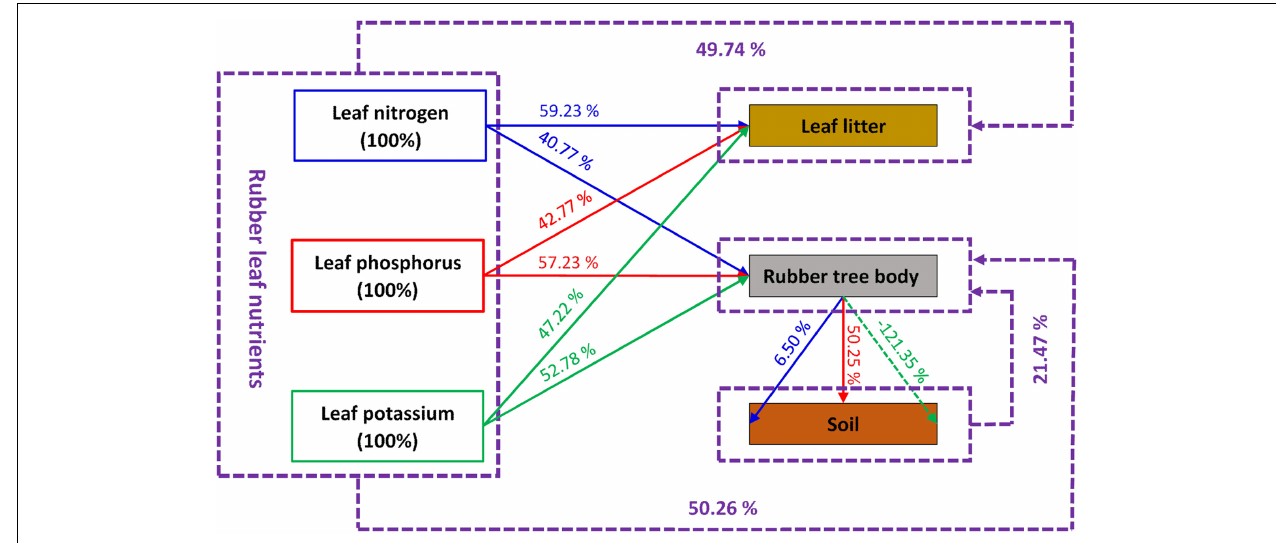
FIGURE 4 | Retranslocation efficiencies of leaf nitrogen (N), phosphorus (P), potassium (K) and comprehensive retranslocation efficiency of rubber trees from mature leaf period to deciduous leaf period. The leaf N retranslocation processes and percentages were shown in blue lines and data; the leaf P retranslocation processes and percentages were shown in red lines and data; the leaf K retranslocation processes and percentages were shown in green lines and data; the comprehensive retranslocation processes and percentages were shown in purple lines and